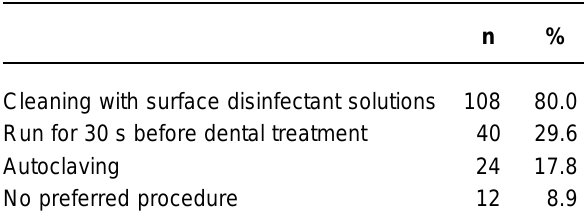
TABLE 8- Use of dental handpieces and other devices attached to air and